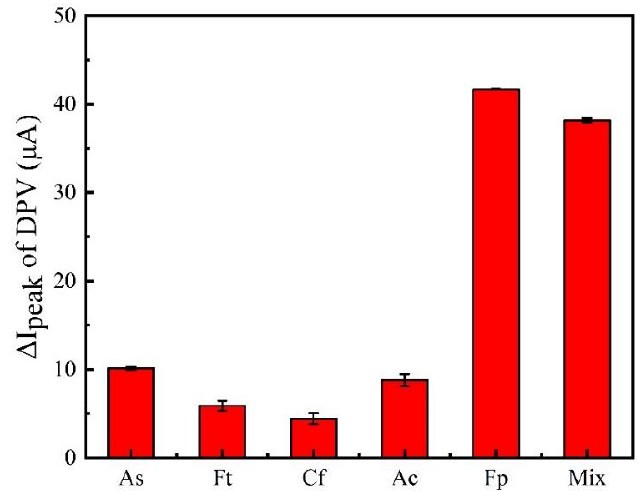
Figure 7. The effects of interfering substances on the detection of fipronil. ΔI peak of DPV variation of aptamer sensor at 10 ng/mL As, Ft, Cf, Ac, 10 ng/mL Fp, and mixed group. Mix denotes the solution containing 10 ng/mL of the above interfering pesticide and 10 ng/mL fipronil.